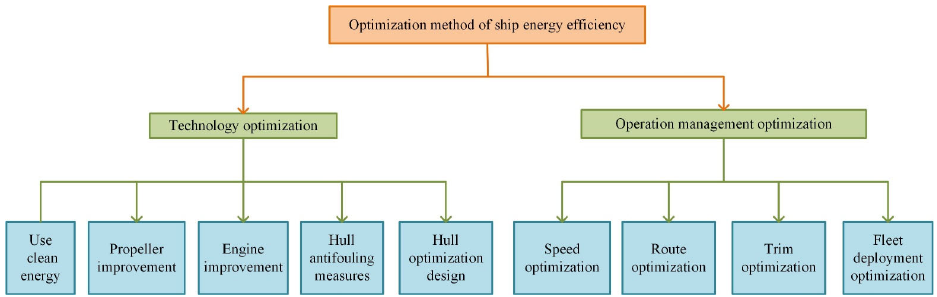
Figure 2. Optimization methods for improving ship energy efficiency [8].